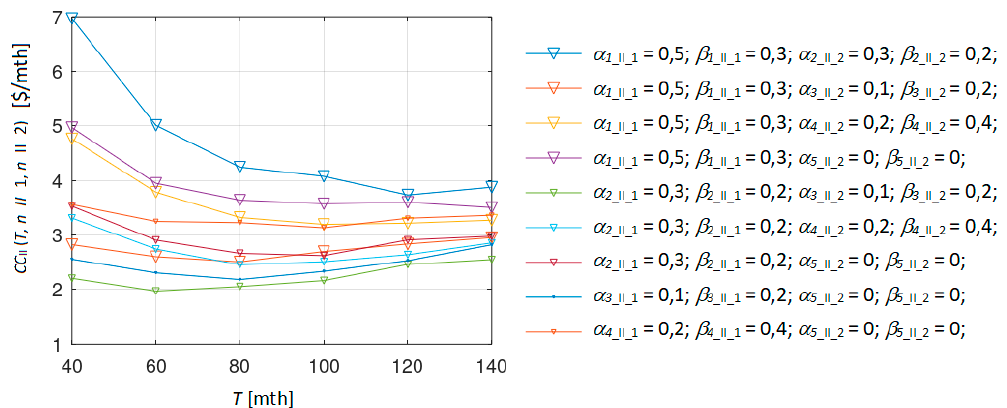
Figure 4. The lowest expected cost per unit time found for the tested one-stage and the two-stage policies.